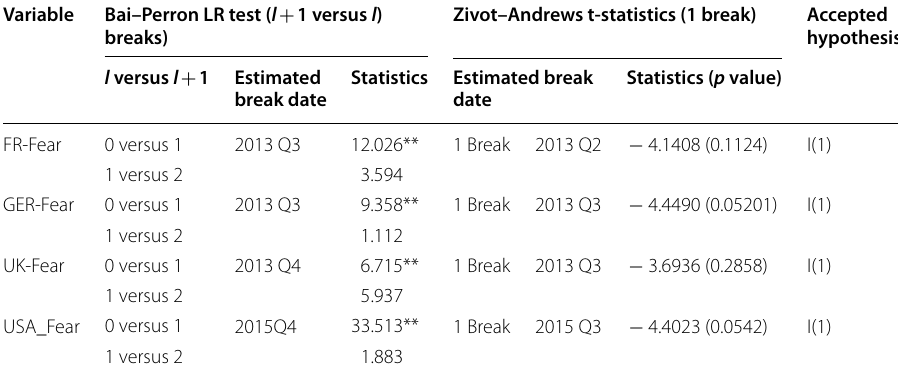
**Indicates the 5% significance level, and I(1) indicates that series is non-stationary and one order integrated